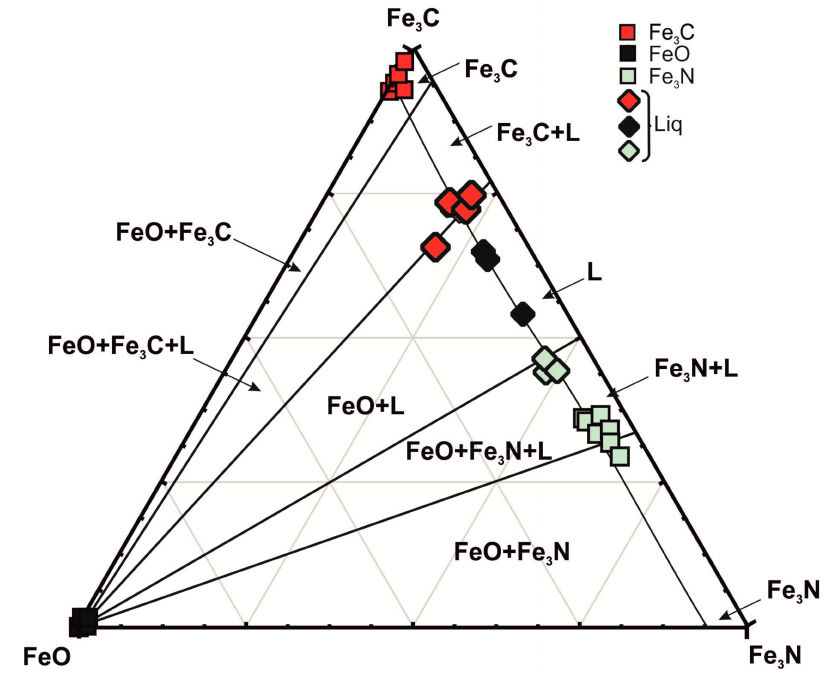
Figure 4. FeO-Fe 3 C-Fe 3 N ternary phase diagram at 7.8 GPa and 1350 C (mol %) and compositions of phases obtained in